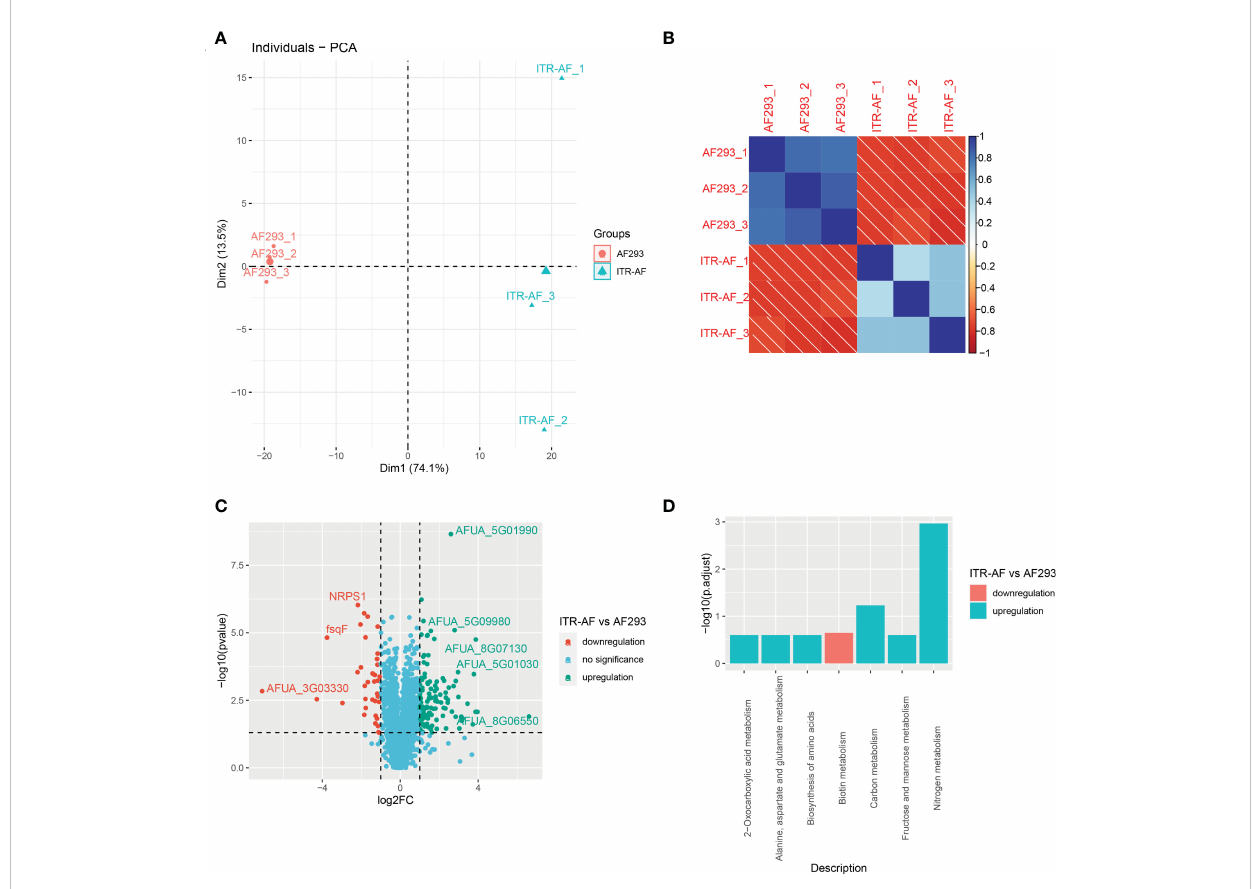
FIGURE 4 Proteomics based on LC – MS/MS showing the characterization of succinylated proteins in A. fumigatus. (A) PCA analysis of all samples based on their protein expression. (B) Correlation heatmap depicting the similarity of all samples. (C) Volcano plots depicting the differentially expressed proteins in ITR-AF relative to that in AF293. P-value was calculated with a two-sided Wilcox rank-sum test. (D) Bubble charts describing the pathways engaged with differential proteins in ITR-AF compared with that in AF293. The p-value was calculated by the hypergeometric